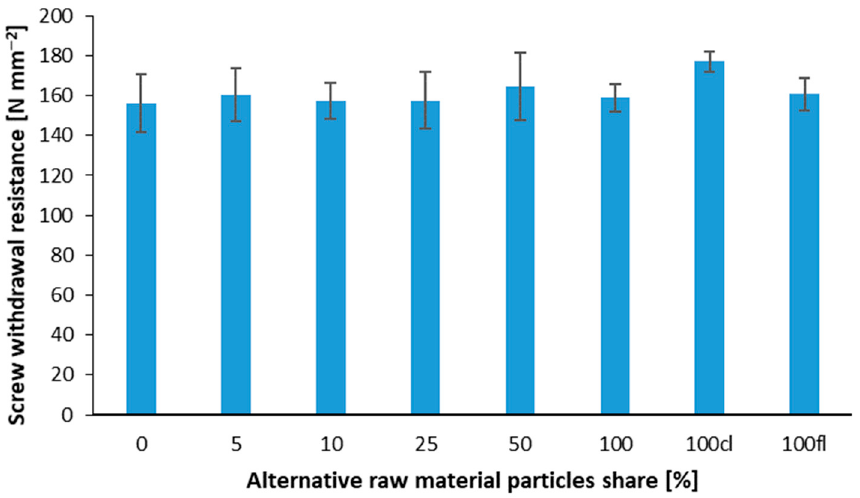
Figure 7. Screw withdrawal resistance of the panels with various branch particles share.